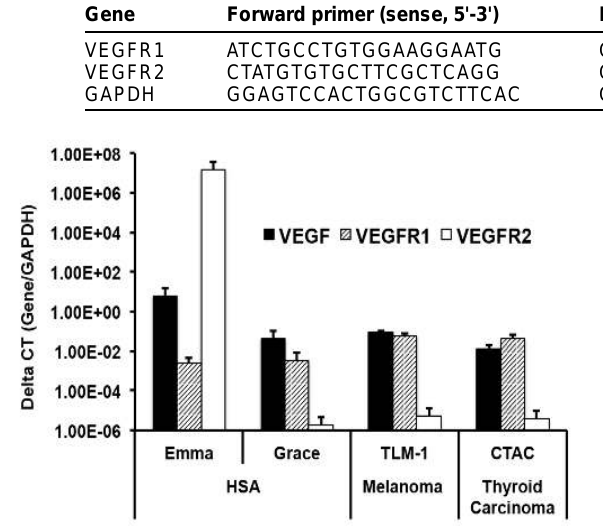
Figure-2. TLM-1 and Grace-HSA cell lines are resistant to paclitaxel (Taxol). Canine HSA (Grace-HSA), dashed line, and melanoma (TLM- 1), solid line, cell lines were cultured for 72 hr with increasing concentrations of paclitaxel (Taxol). Viability was measured